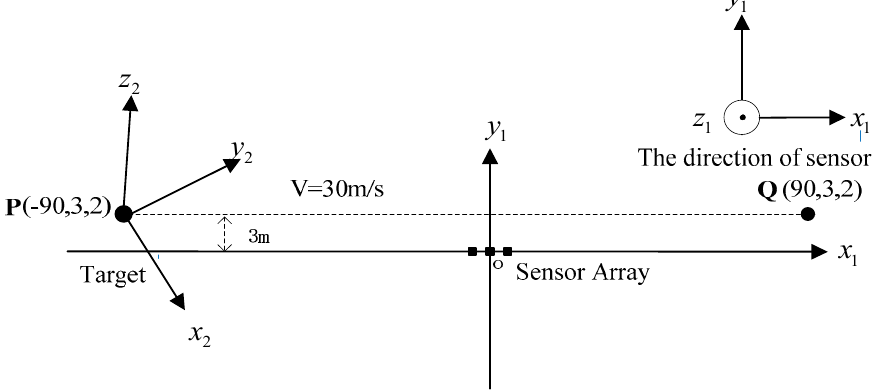
Figure 10. The overhead view of three collinear magnetic sensors.